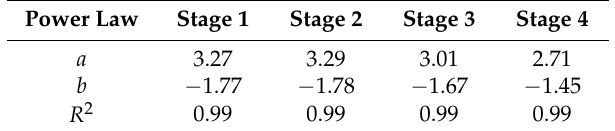
Table 6. Power law distribution of degree.